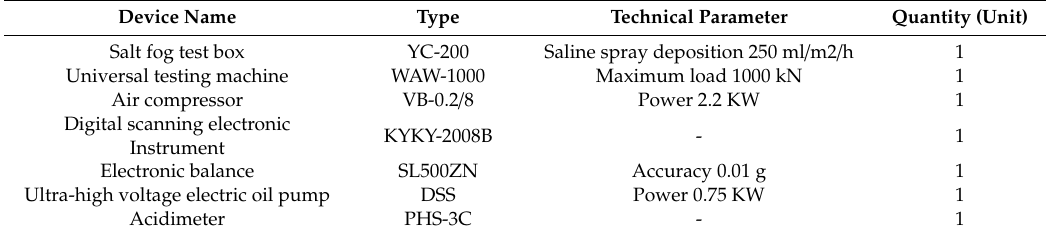
Figure 1. Loading schematic diagram. Table 1. Test equipment.